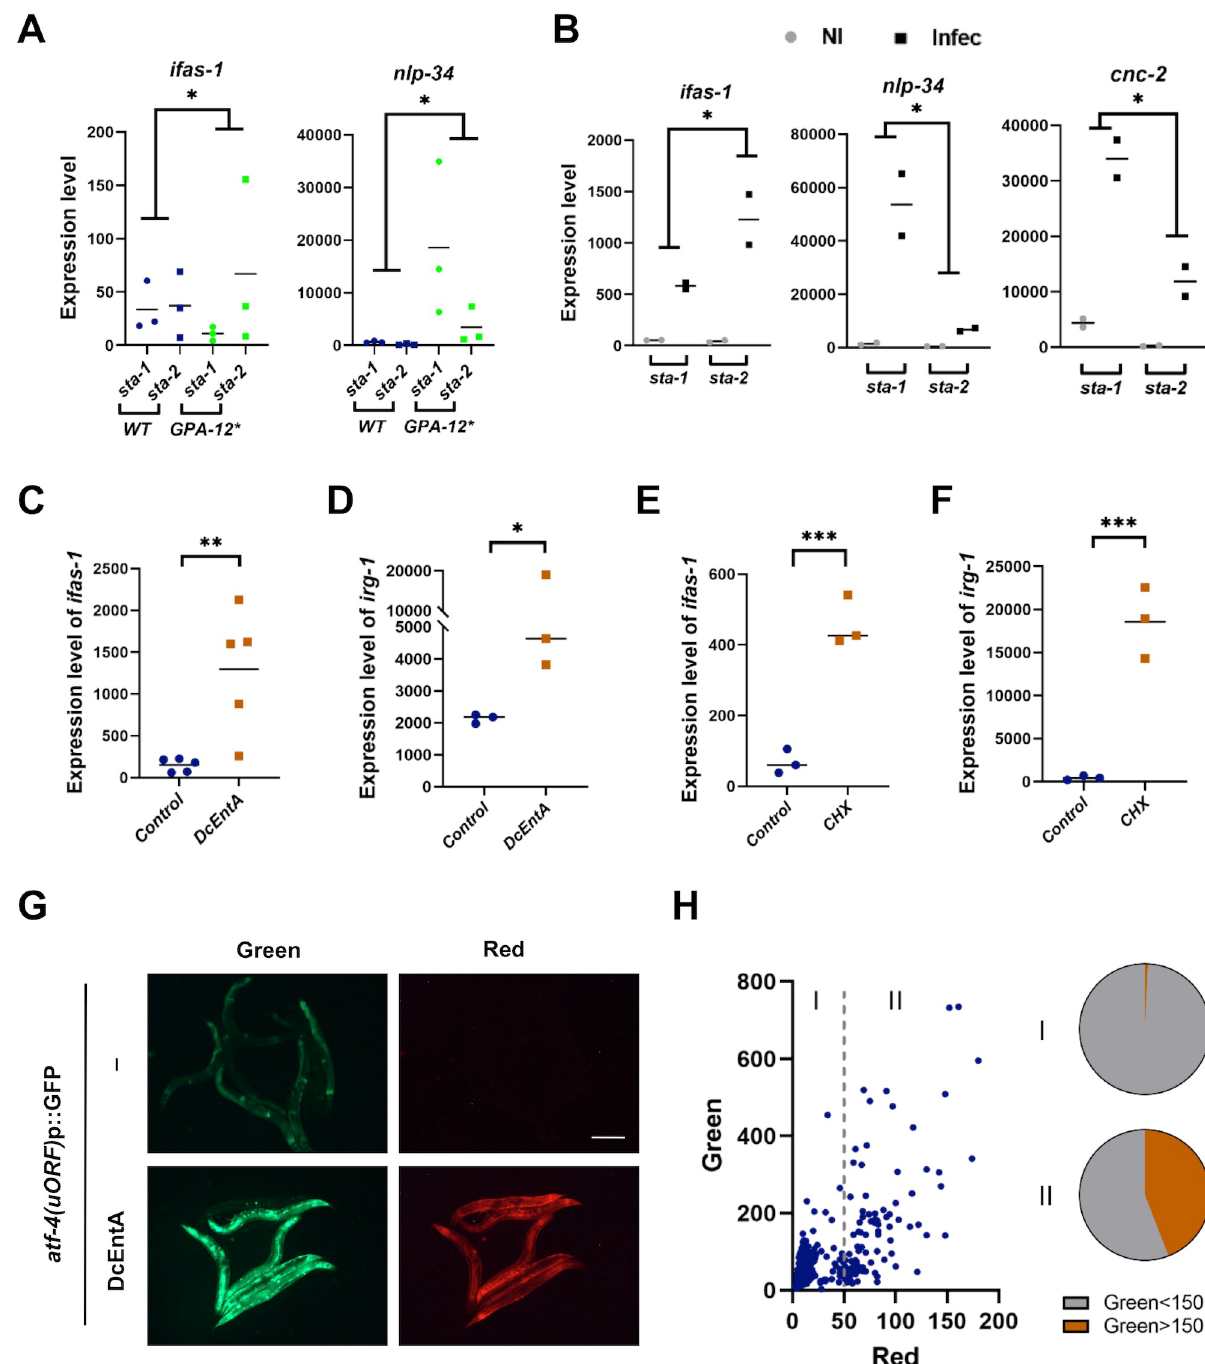
Fig 5. DcEntA induces expression of ifas-1 , a target of negative regulation by sta-2 , and inhibits translation. ( A ) Quantitative RT-PCR analysis of the expression of ifas-1 and nlp-34 in control (hygR; frIs7 IG1864) worms and worms expressing GPA-12 � (IG1389) following RNAi against sta-1 or sta-2 . Data from three independent experiments are shown. ( B ) Quantitative RT-PCR analysis of the expression of ifas-1 , nlp-34 and cnc-2 following RNAi against sta-1 or sta-2 in worms infected for 18h (Infec) and non-infected (NI) controls in the epidermis-specific RNAi strain IG1502. Data from two independent experiments are shown. ( C, D ) Quantitative RT-PCR analysis of the expression of ifas-1 ( C ) and irg-1 ( D ) genes in young adult worms carrying hygR and frIs7 with (IG1942) or without DcEntA (control; IG1864). ( E, F ) Quantitative RT-PCR analysis of the expression of ifas-1 ( E ) and irg-1 ( F ) in control worms (carrying frIs7 [ nlp-29p :: GFP ; col-12p :: dsRed ]; IG274) or following exposure to cyclohexamide (CHX) for 6 h. ( G ) Representative fluorescence images of adult worms carrying an atf-4p(uORF) ::GFP (Green) reporter also expressing DcEntA::mKate2 (Red, IG2044; bottom panels) and their siblings without the DcEntA transgene (upper panels). Scale bar, 200 μ m. ( H ) Relative green fluorescence plotted against